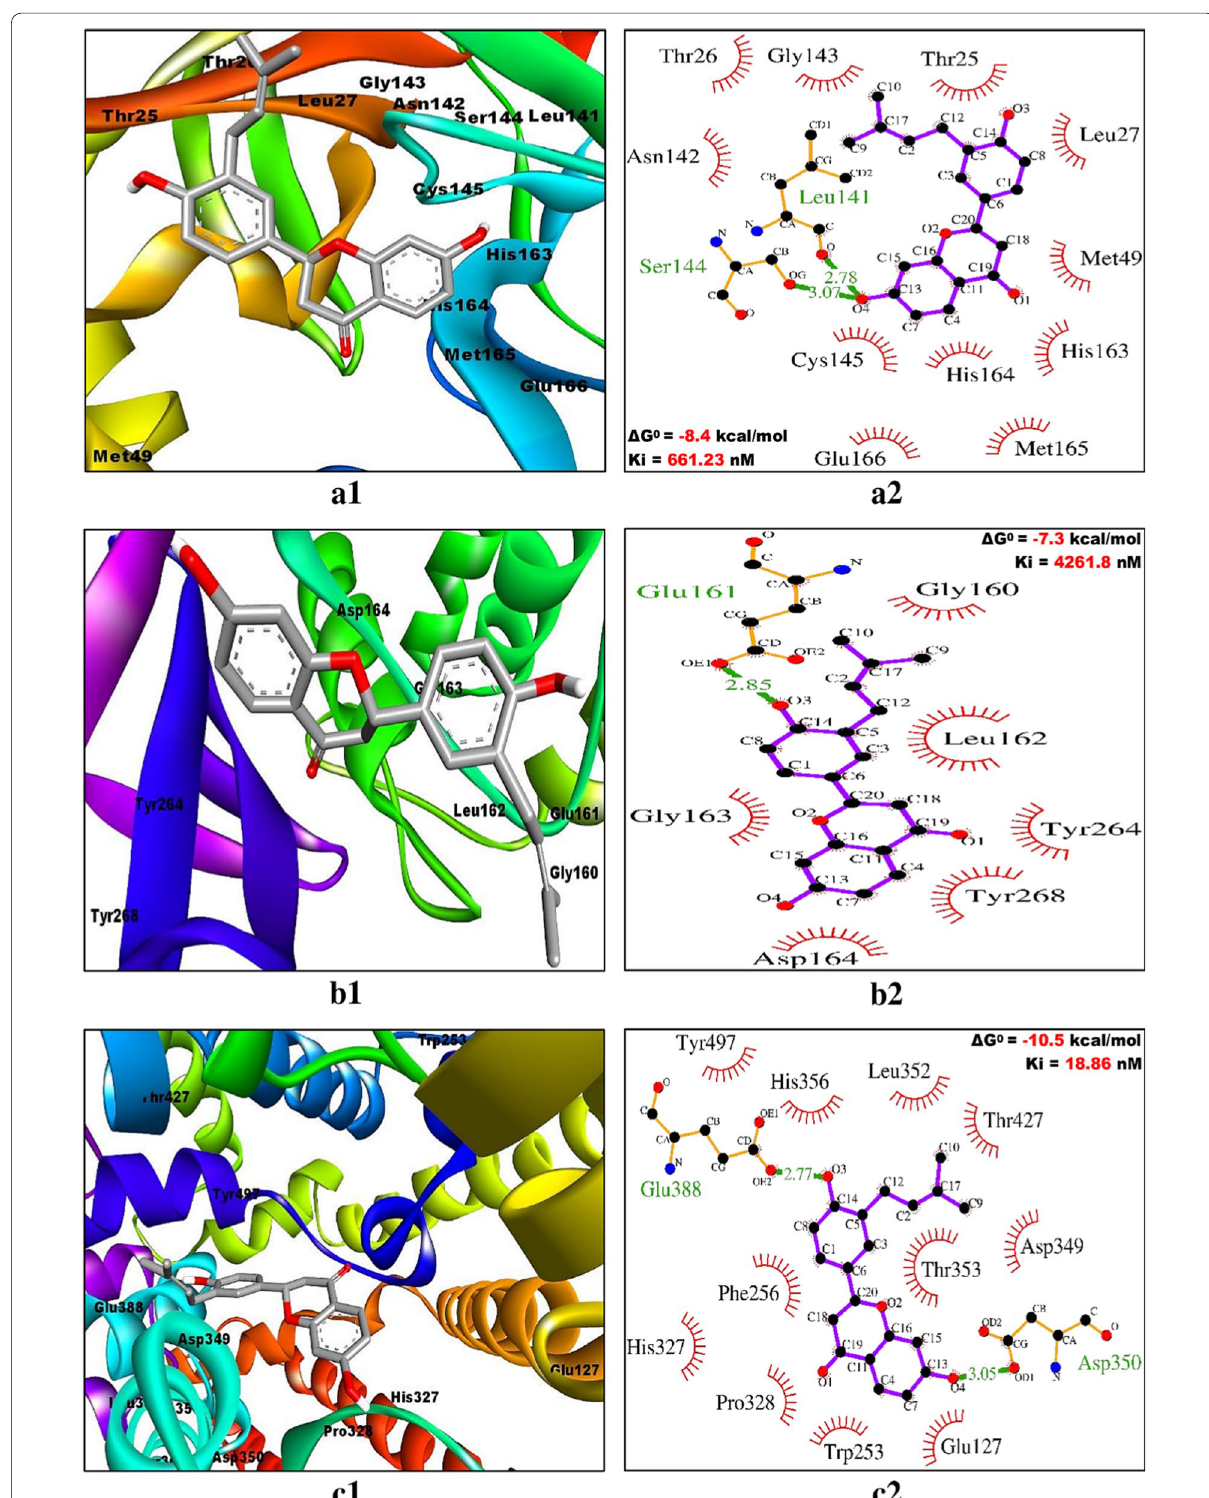
Fig. 4 Binding poses (within the active site) and molecular interaction between C43/abyssinone II and different targets of COVID-19. a1 , a2 C43/ abyssinone II and Mpro/3CLpro, b1 , b2 C43/abyssinone II and PLpro and c1 , c2 C43/abyssinone II and ACE2. Inside the active site, targets are illustrated as solid ribbon and the bound ligands as stick. The molecular interactions are represented by the green dashed lines for hydrogen bonds and semi-arcs with red eyelashes for hydrophobic